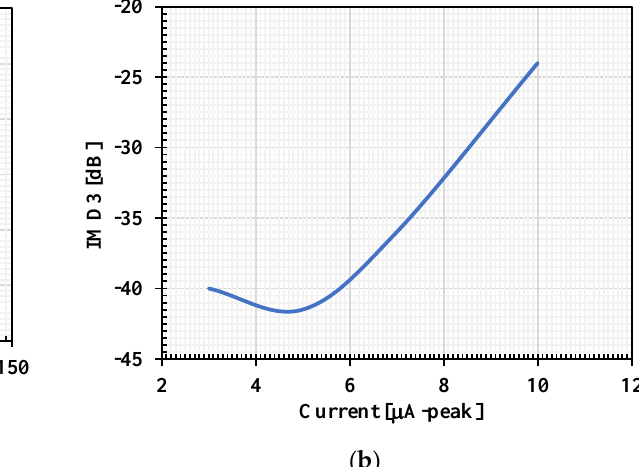
Figure 12. The simulated THD of the LP filters with different amplitude of input signal at 100 Hz: